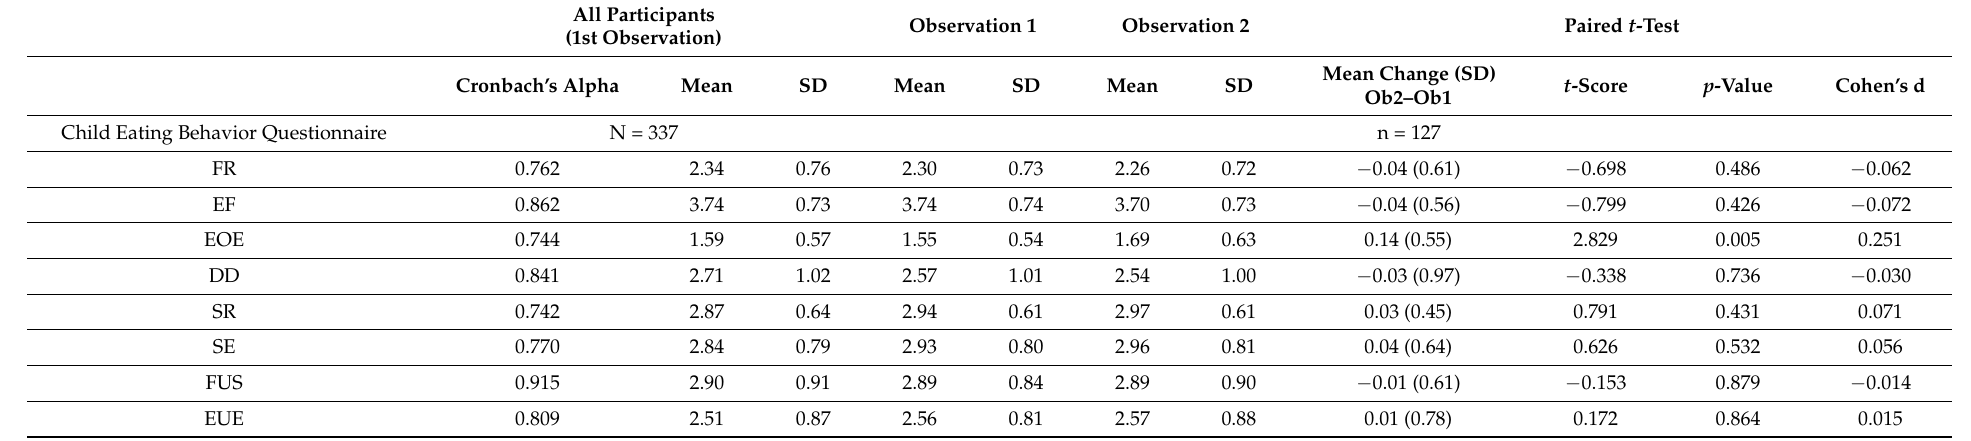
Table 3. Paired t -tests to determine age-related changes within individuals for Child Eating Behavior Questionnaire subscales.